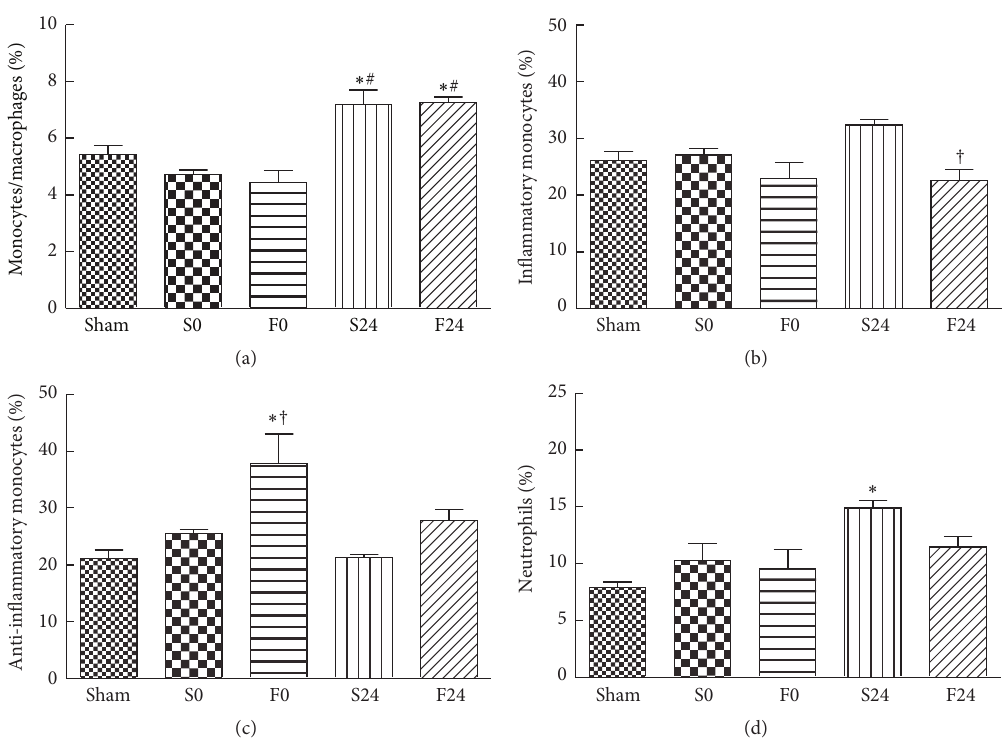
Figure 1: Distribution of blood (a) monocytes/macrophages (F4/80 in CD45), (b) inflammatory monocytes (Ly 6 C hi CCR 2 hi in CD45 F4/80), (c) anti-inflammatory monocytes (Ly 6 C low CCR 2 low in CD45 F4/80), and (d) neutrophils (Ly 6 G hi CXCR 2 + in CD45). For analyzing monocytes/macrophages in blood, mononuclear cells were first identified on the basis of low FSC and SSC. CD45 mononuclear cells were gated and cells expressing F4/80 were further analyzed. Monocyte subpopulations were presented as percentages of Ly 6 C hi CCR 2 hi and Ly 6 C low CCR 2 low among CD45 F4/80 mononuclear cells. Population of neutrophils is presented as percentage of Ly 6 G hi CXCR 2 + in CD45 + cells. Sham group, without IR procedure; S0 group, ischemic mice pretreated with saline injection sacrificed immediately after onset of reperfusion (time 0); F0 group, ischemic mice pretreated with FO-based lipid emulsion sacrificed at time 0; S24, ischemic mice pretreated with saline injection sacrificed at 24 h after reperfusion (time 24 h); F24, ischemic mice pretreated with FO-based lipid emulsion sacrificed at time 24 h. Data are presented as the mean ± SEM ( 𝑛 = 8 ). Differences among groups were analyzed by one-way ANOVA with Tukey’s post hoc test. ∗ Different from the sham group. † Different from the saline (S) group at the same time point. # Different from other time points in the same group ( 𝑝 < 0.05